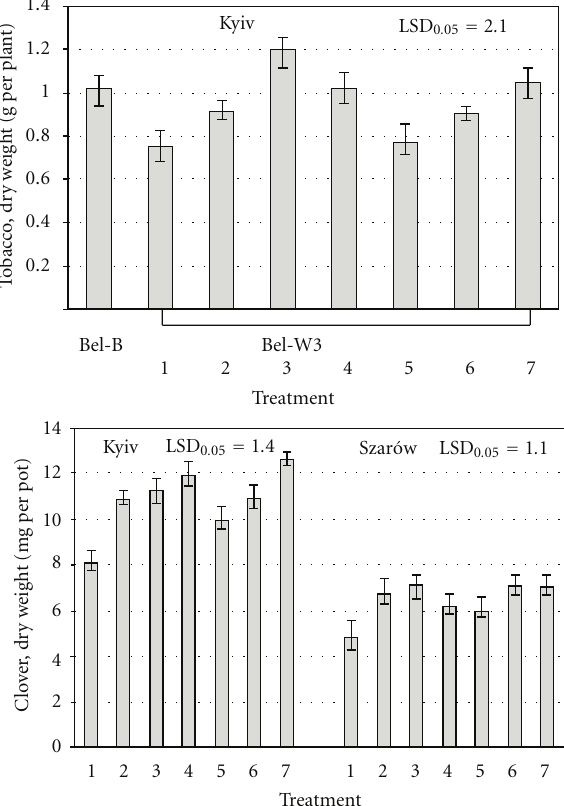
Figure 3: Mean dry weight of clover and tobacco sprayed with distilled water (control) (1), solutions of EDU, 150mg L − 1 (2), “Emistym C”, 150 mgL − 1 in Kyiv and 30mg L − 1 in Szar´ow (3), “Agrostymulin”, 150 mgL − 1 in Kyiv and 30 mgL − 1 in Szar´ow (4), “Quadris”, 300 mgL − 1 in Kyiv and 150mg L − 1 in Szar´ow (5), “Flint”, 300 mgL − 1 in Kyiv and 150mg L − 1 in Szar´ow (6), “Strobi”, 300 mgL − 1 in Kyiv and 150 mgL − 1 in Szar´ow (7) on the last day of exposure to ambient ozone. Vertical bars represent standard error. LSD 0 . 05 — least significant di ff erence at P < 0 .